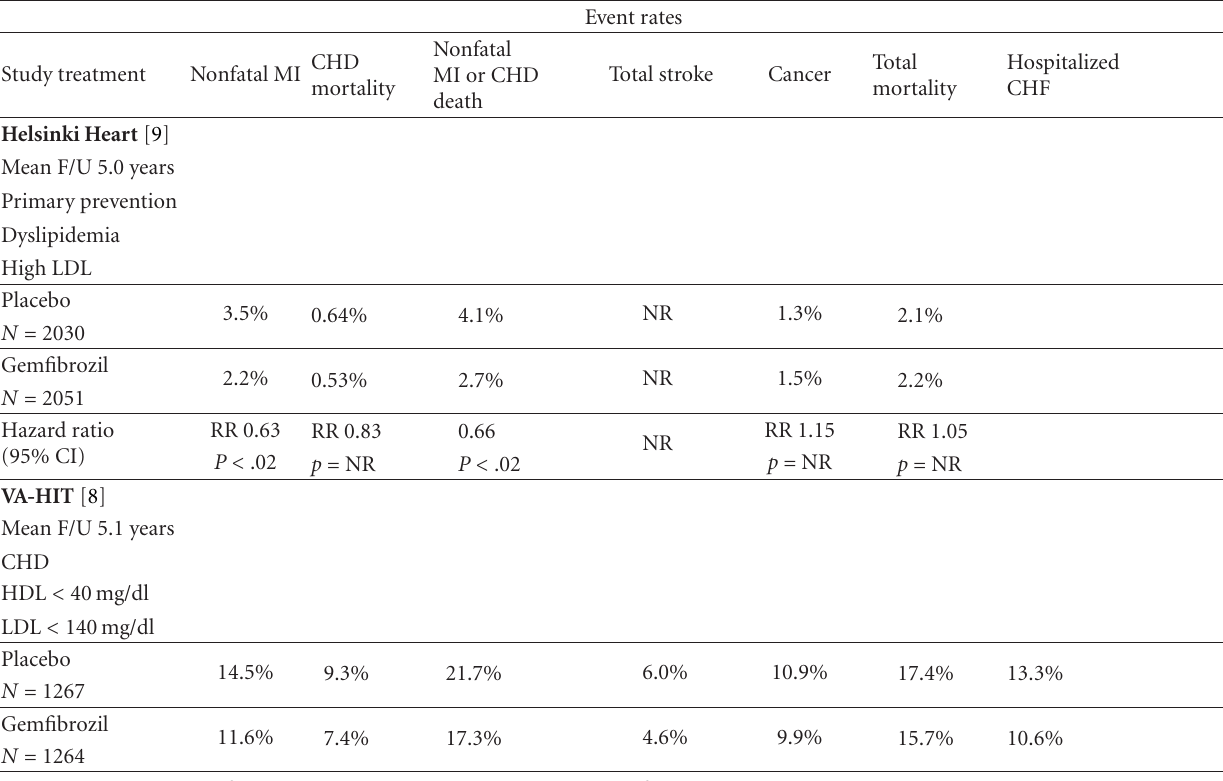
Table 1: Selected morbidity and mortality outcomes in large, long-term fibrate trials. CHD = coronary heart disease, CVD = cardiovascular disease, MI = myocardial infarction, NR = not reported, ns = reported as “not significant,” RR = Crude relative risk calculated form reported number of events; hazard ratio was not